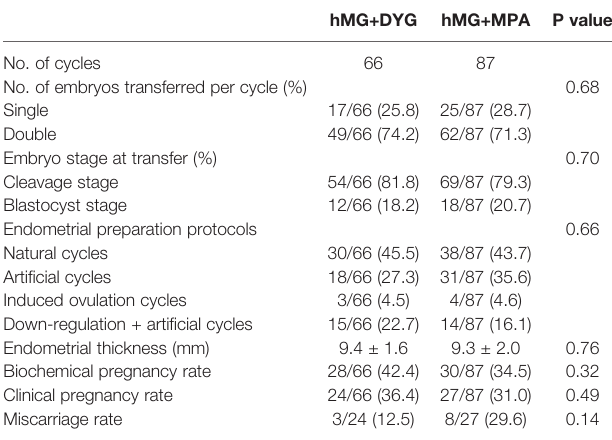
Data are presented as the mean ± SD for continuous variables and n (%) for categorical